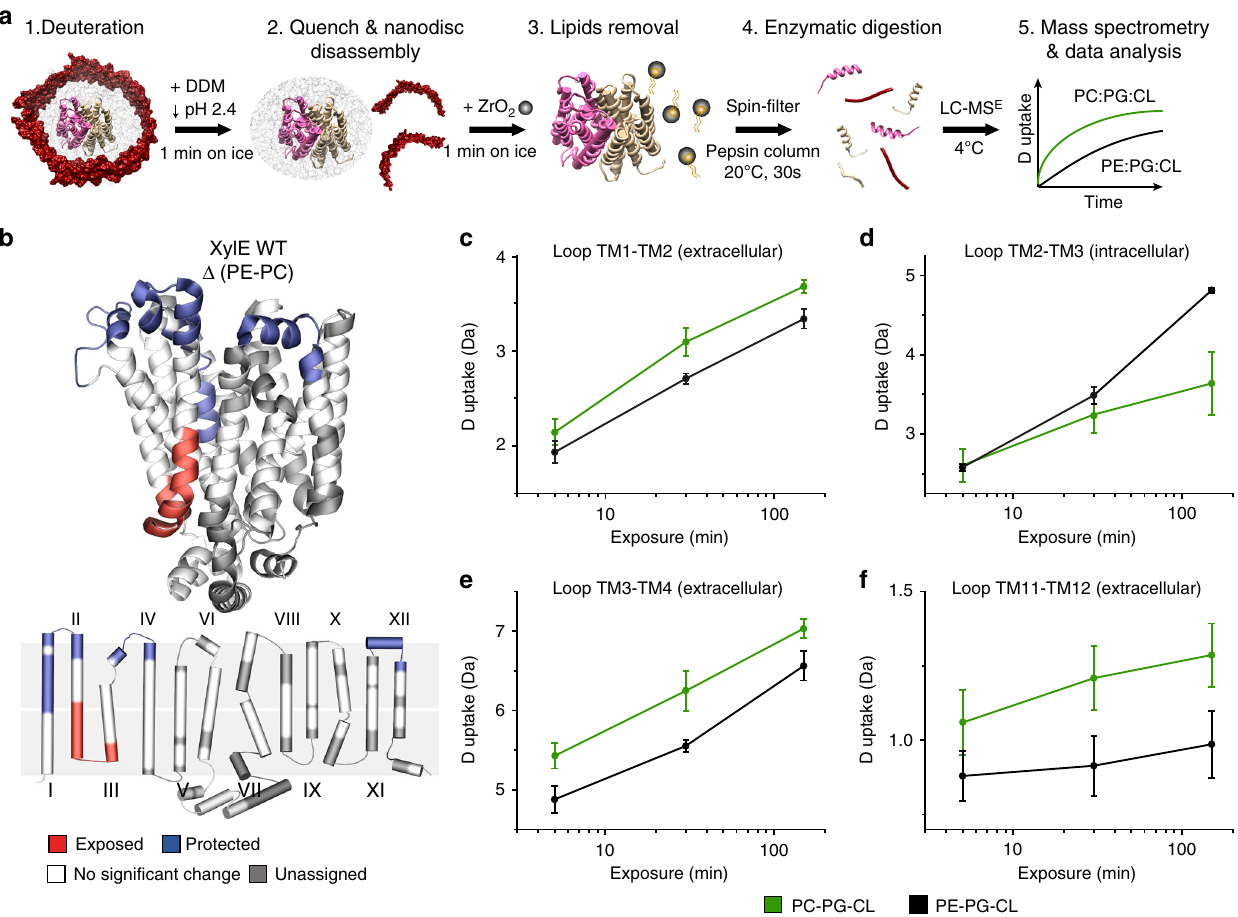
Fig. 3 Lipid – protein interactions regulate the conformational equilibrium. Δ HDX of XylE WT in PE vs. PC nanodiscs shows that PE promotes the IF conformation. a Optimized experimental procedure for HDX-MS of a transporter in nanodiscs of different lipid compositions. Following deuteration at speci fi c time points, the exchange reaction is quenched and the nanodiscs disassembled with detergent DDM. Lipids are removed by adsorption, before enzymatic digestion and peptides identi fi cation by MS. The mass uptake of the protein in both lipid environments is then compared. b Δ HDX of WT XylE in DOPE-PG-CL nanodiscs (native-like) minus DOPC-PG-CL (control) nanodiscs mapped on the PDB structure and the topological representation. c Representative deuterium uptake plots for peptide 28 – 38, ( d ) 70 – 88, ( e ) 108 – 122, ( f ) 430 – 434 in DOPC-PG-CL nanodiscs (green) and DOPE-PG-CL nanodiscs (black). Standard deviations for each time point are plotted as error bars ( n = 3). All measurements were performed in